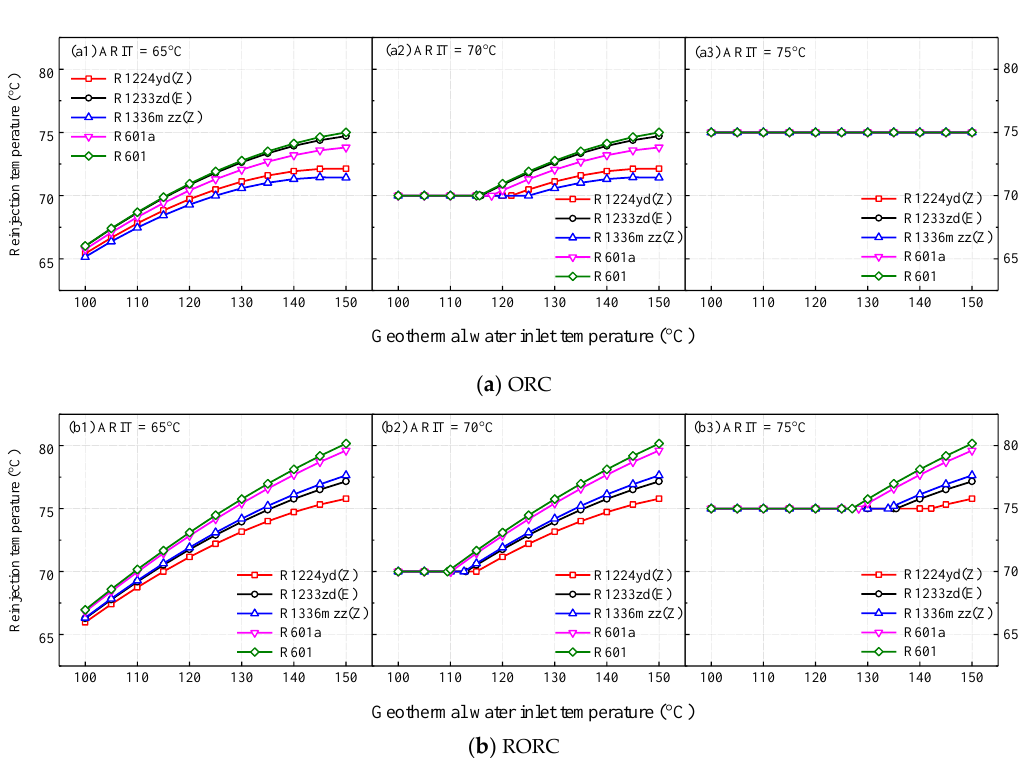
Figure 4. Optimal evaporation temperatures of the selected working fluids for ( a ) ORCs and ( b ) RORCs for various geothermal brine inlet temperatures (BITs) and allowed reinjection temperatures (ARITs).